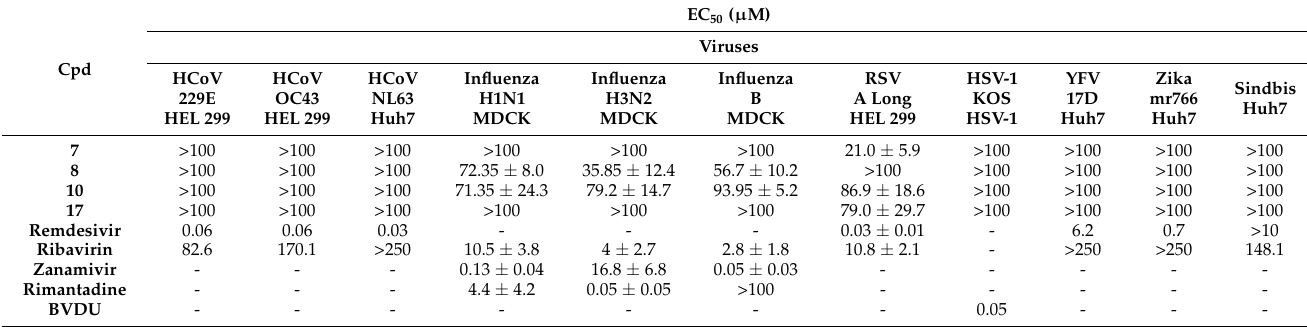
Table 5. In vitro antiviral